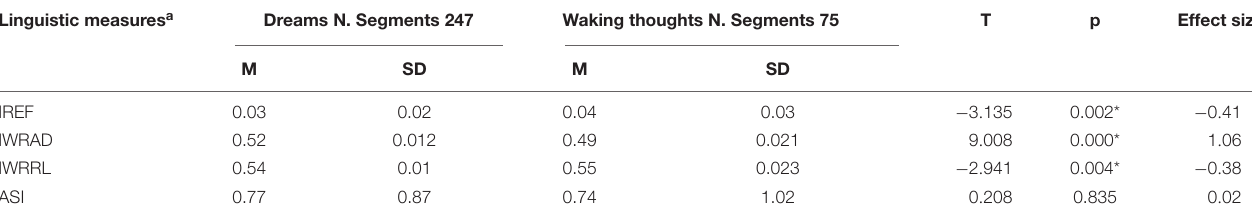
TABLE 1 | Comparison COVID-19 pandemic dreams and waking thoughts writing. Linguistic measures a Dreams N. Segments 247 Waking thoughts N. Segments 75 T